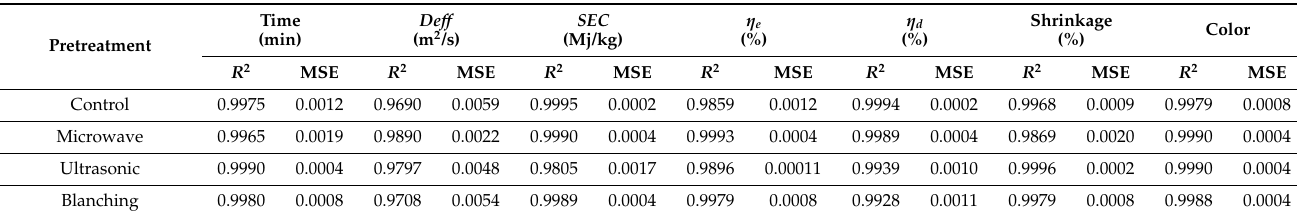
Table 9. Prediction of the response parameters for turnip drying under an HCIR dryer with different pretreatments by